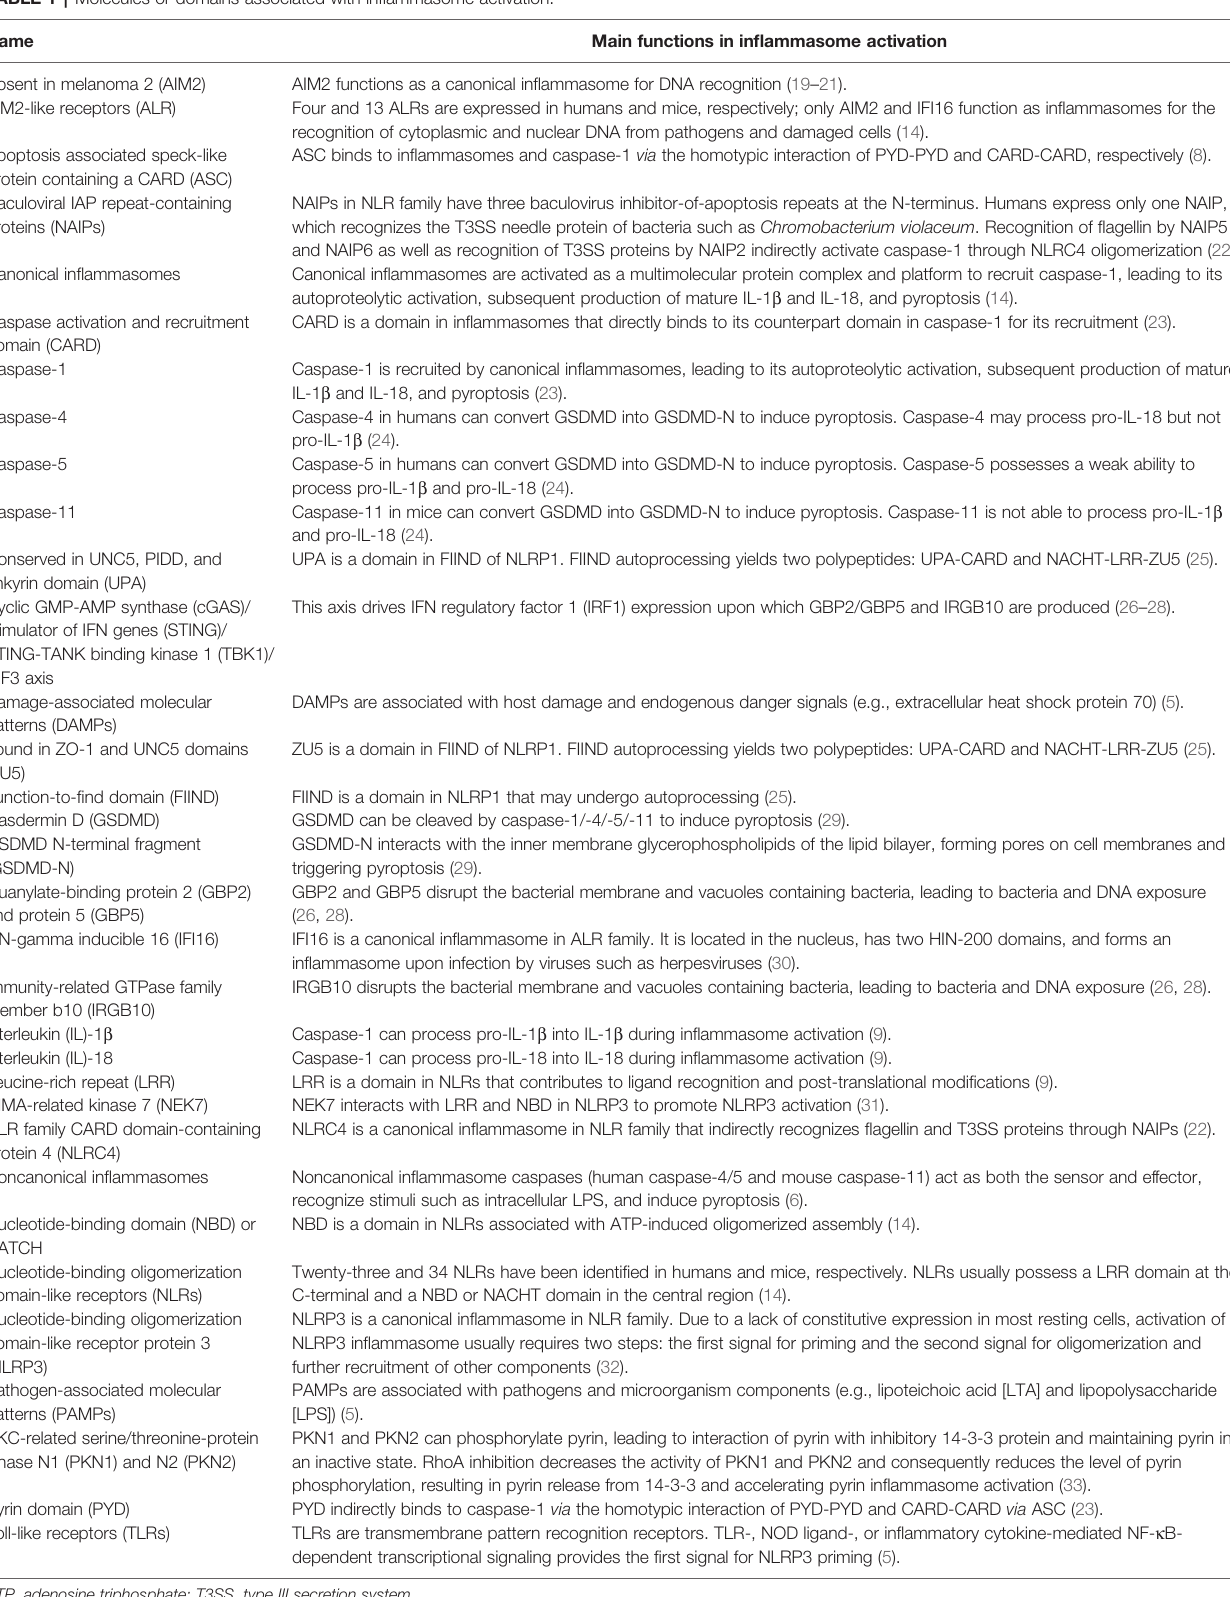
TABLE 1 | Molecules or domains associated with in fl ammasome